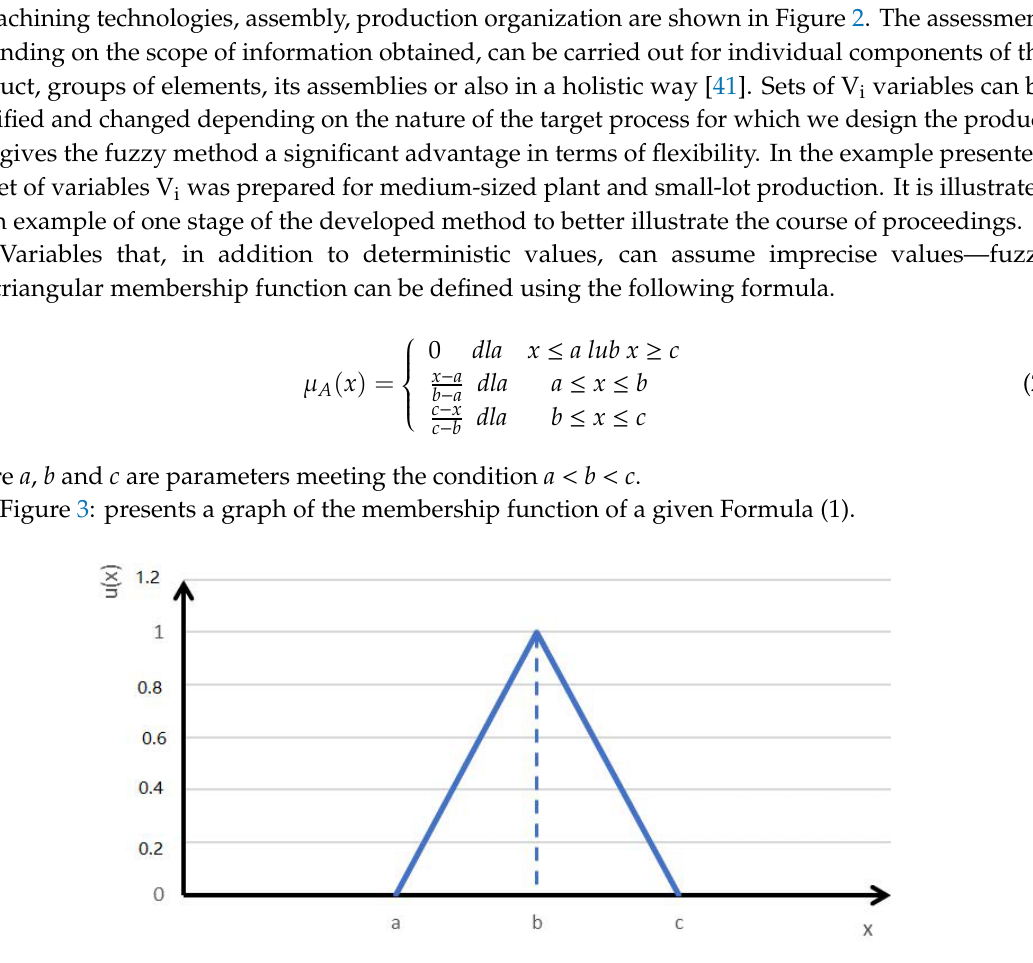
Figure 3. Graph of the triangular membership function described by the Formula